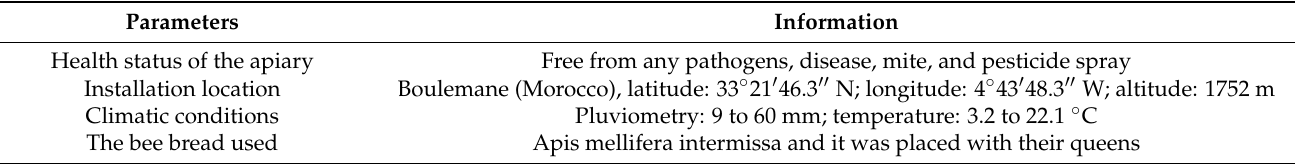
Table 1. Apiary information and its geographical